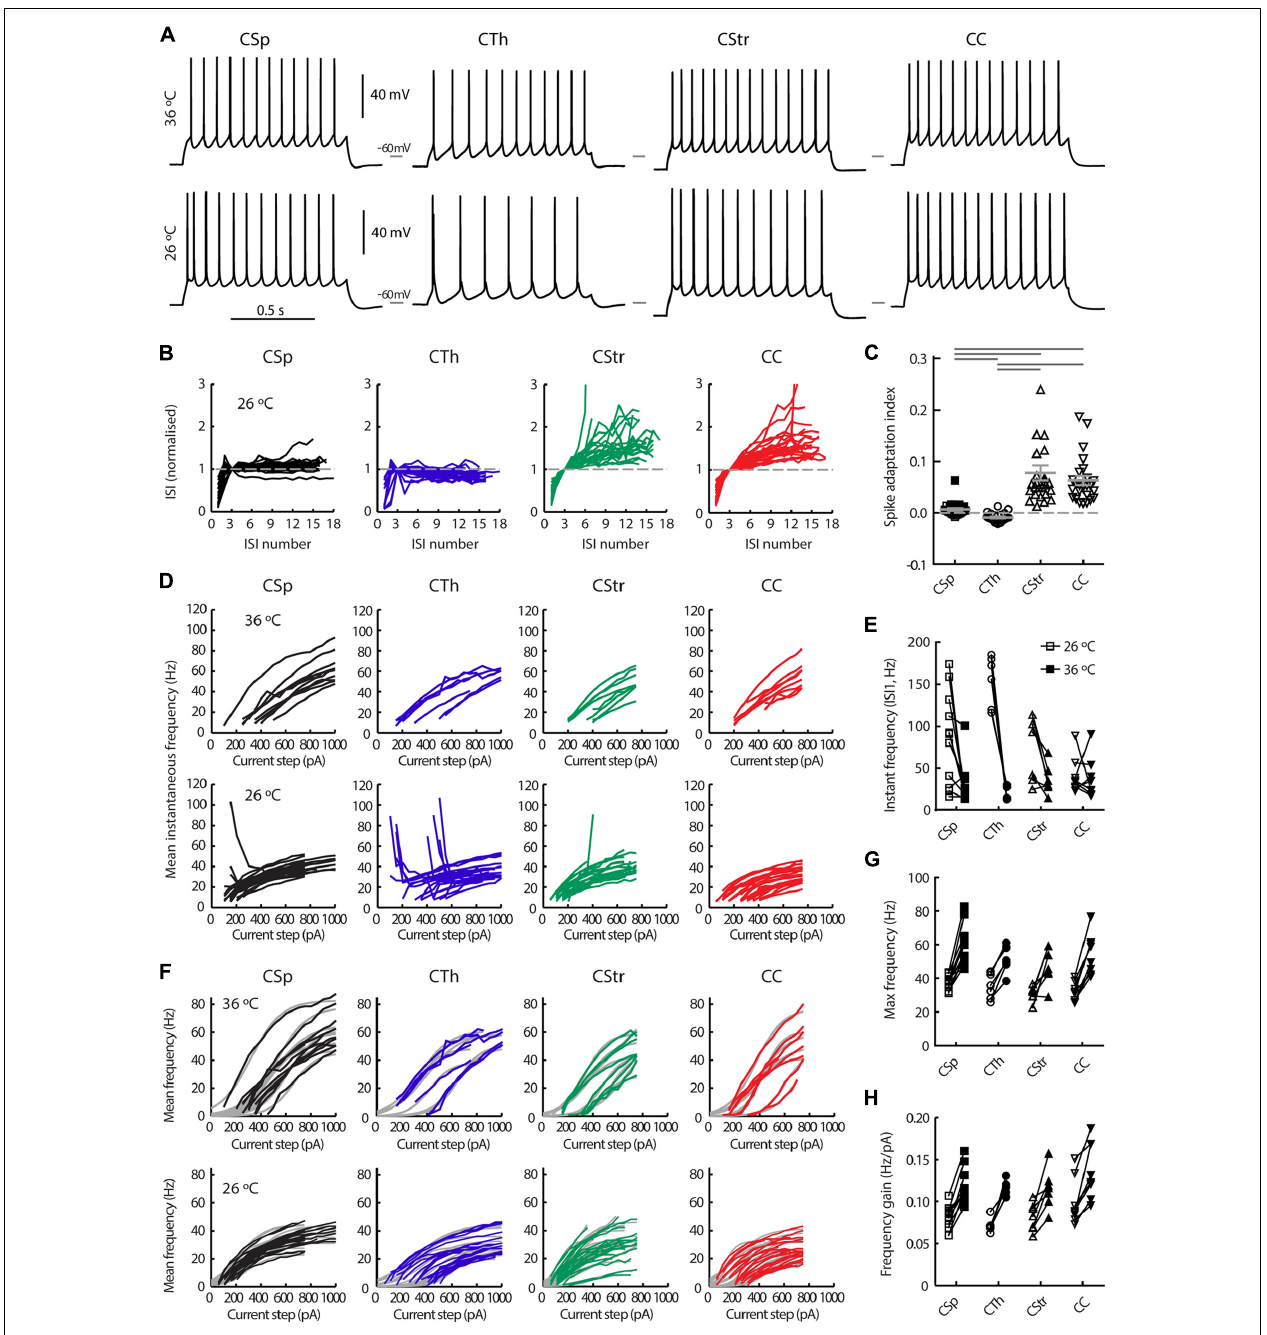
FIGURE 3 |Action potential firing behavior of M1 layer 5 neurons grouped by projection target. (A) Firing responses of CSp, CTh, CStr and CC neurons during a 1 slong depolarising current injection recorded in the same neuron at 36 and 26 ◦ C. (B) Normalized inter spike interval (ISI) plots for all neurons in each group derived from episodes with a firing frequency closest to 15 Hz at 26 ◦ C. (C) The spike adaptation index, defined as the slope of the linear regression of the ISI plots in B, from the 3 rd ISI onward ( C , means ± SEM for each group are shown in gray, filled and open squares respectively for lumbar and cervical CSp neurons where visible). Horizontal gray bars indicate group-wise differences of the Log normalized data ( p < 0.001, one-way ANOVA and Tukey’s post hoc test). (D) Mean instantaneous frequency